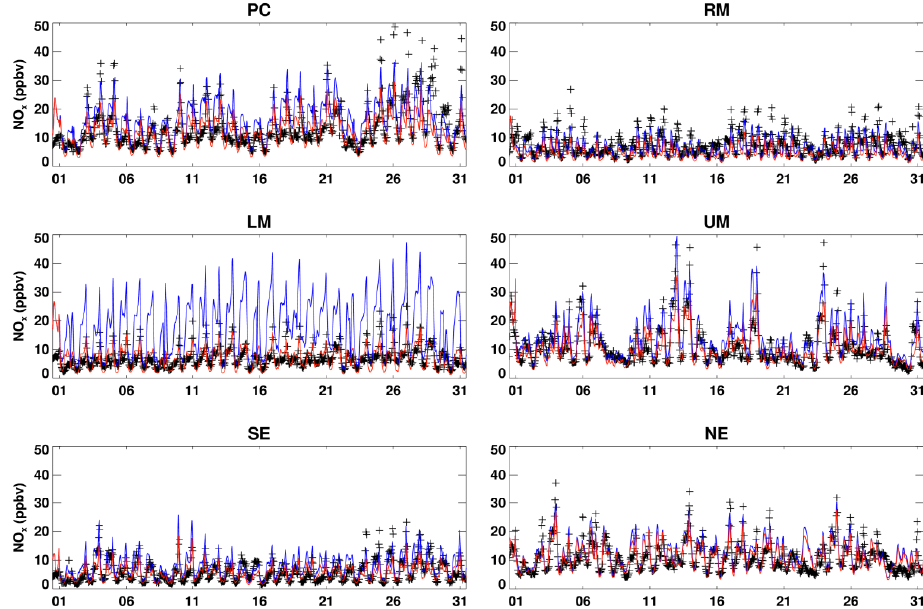
Fig. 2. Surface NO x concentrations at EPA AQS stations (black crosses), corresponding CMAQ simulations with the baseline emissions, BASE2009 (blue), and CMAQ simulations including GOME-2-adjusted NO x emissions, GOME2009 (red) over six geological regions (see Fig. 1, PC: Pacific Coast, RM: Rocky Mountain, LM: Low Middle, UM: Upper Middle, SE: South East, and NE: North East) for August 2009.